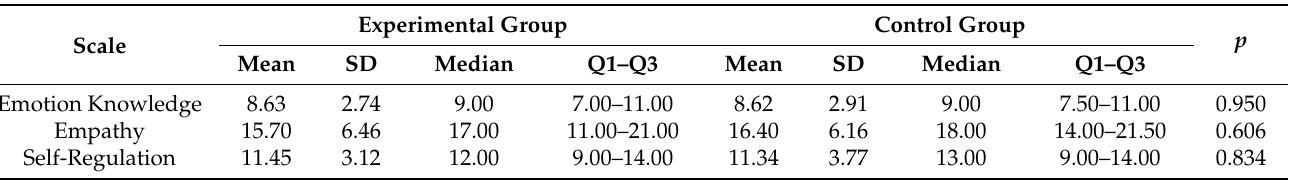
Table 6. Comparison of the experimental and control groups according to the EMK screening scale estimates before the ELLA